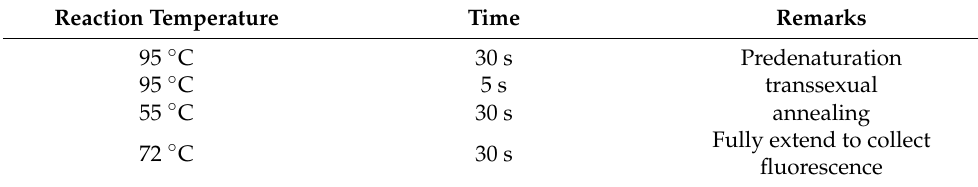
Table 8. PCR reaction